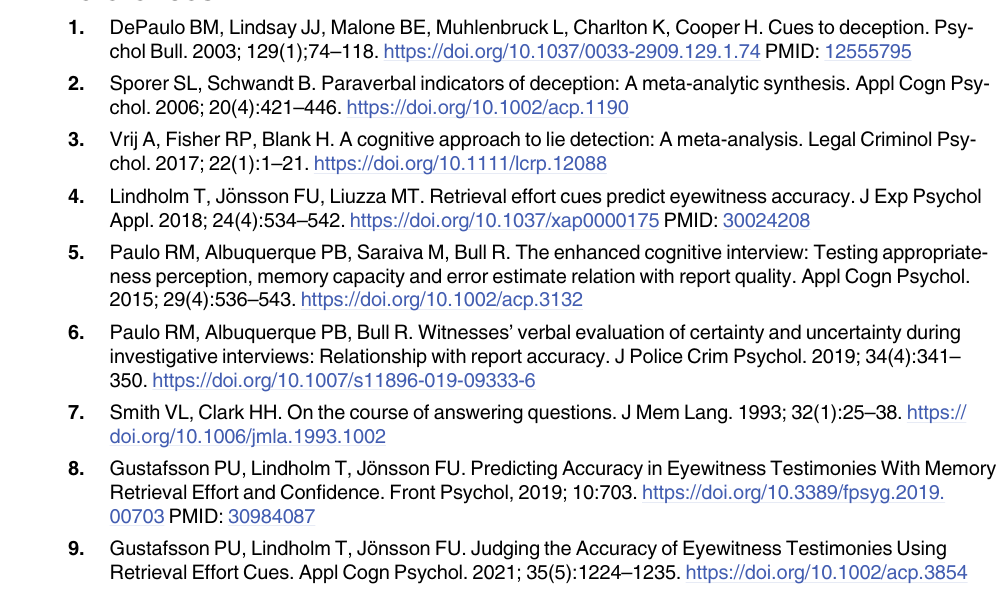
S1 Table. Percentage distribution of ratings for each level of confidence across accuracy, time, and repetition. S2 Table. Mediations between confidence and accuracy for each effort